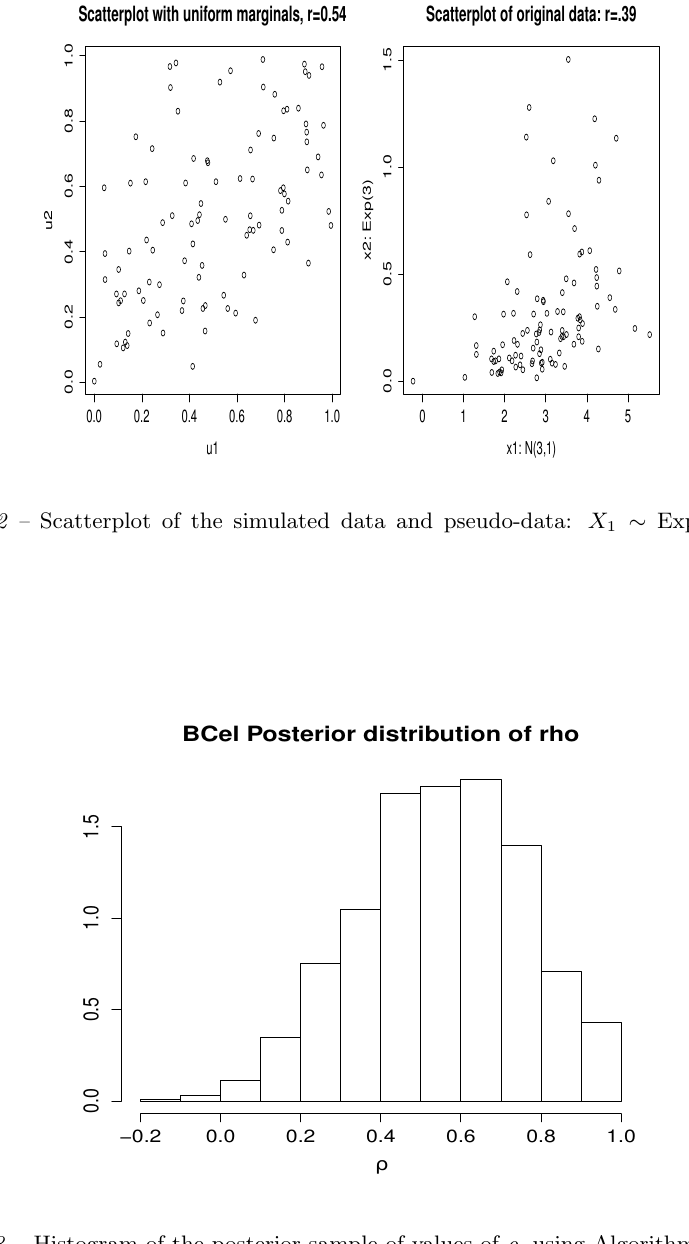
Figure 3 { Histogram of the posterior sample of values of ρ , using Algorithm